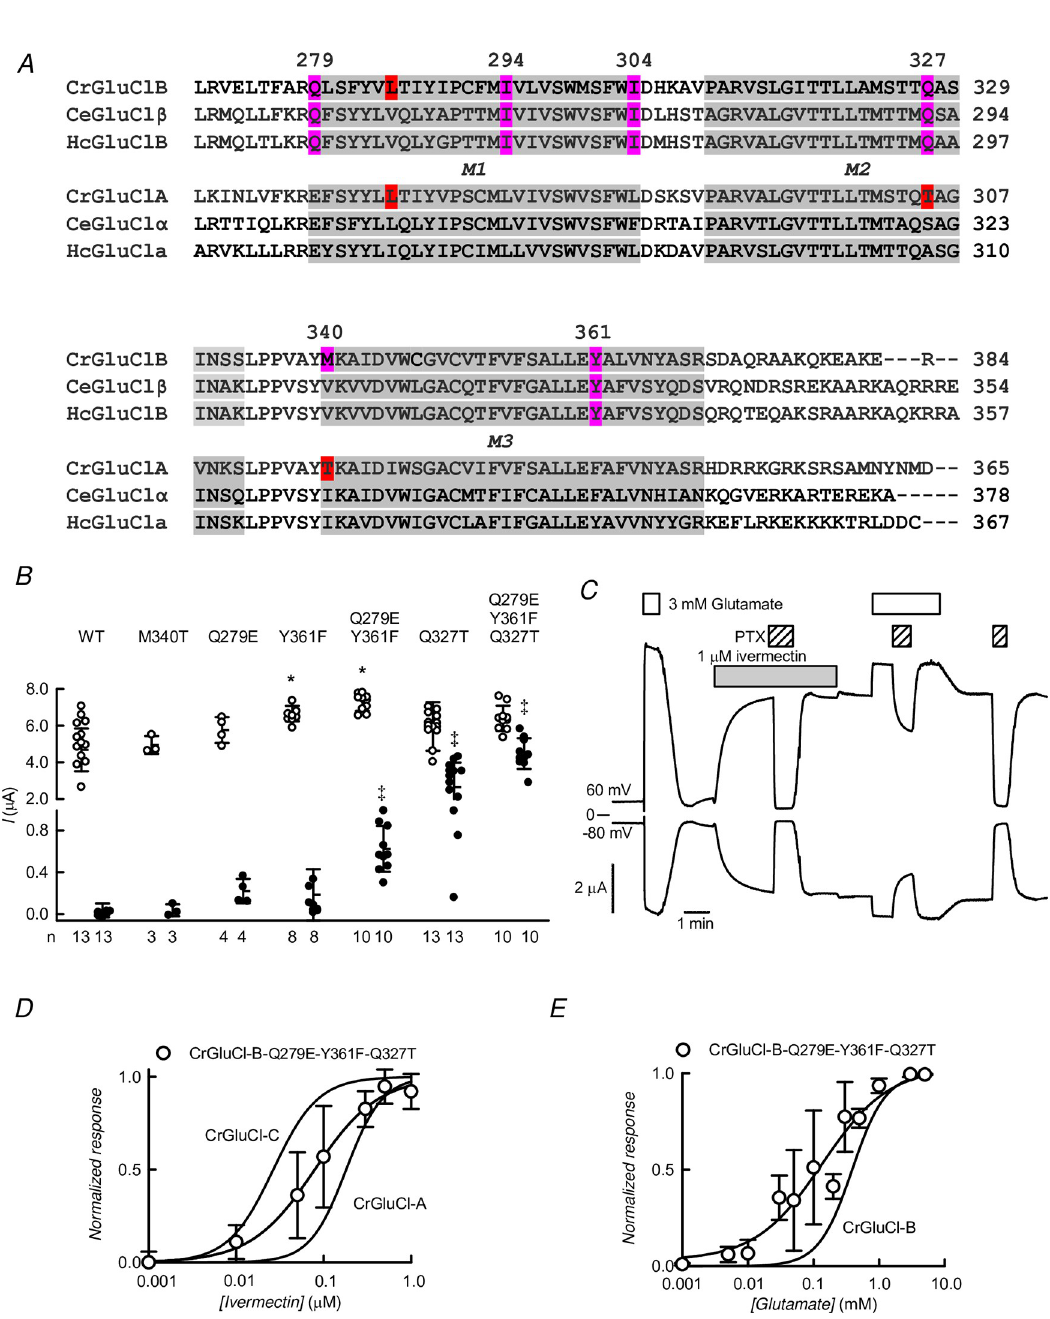
Fig 15. Mutational analysis of CrGluCl-B ivermectin-resistance. A. Partial sequence alignment of CrGluCl-B and CrGluCl-A. Also shown are homologous regions of GluCl α and β subunits of H . contortus and C . elegans . Highlighted in red are residues identified as interacting with ivermectin in docking experiments with CrGluCl-A. Magenta residues are those at variance between C . rogercresseyi GluCl A and B subunits and are conserved in the nematode respective subunits. B. Currents induced in CrGluCl-B WT or its indicated mutants by 3 mM glutamate (open circles) or 1 μ M ivermectin (black circles). Results are given as individual points and means ± SD given under the abscissa for WT CrGluCl-B and for its M340T, Q279E, Y361F, Q279E-Y361F, Q327T and Q279E-Y361F-Q327T mutants. ANOVA with Bonferroni correction analysis of the glutamate effect shows no significant difference between mutants and WT except as indicated by � (P < 0.001). Regarding ivermectin effect, one-sample t-tests showed significant effects of the drug in all cases, except for the WT receptor and for its M340T mutant. The effect of ivermectin on the mutants compared with that on the WT subunit reached significance as tested by ANOVA as indicated (‡, P < 0.05). C. Currents taken at 60 and -80 mV in a recording of the Q279E-Y361F-Q327T mutant. D and E. Concentration-dependence of the effects of ivermectin and glutamate on CrGluCl-B-Q279E-Y301F-Q327T triple mutant. Concentration-dependence data for ivermectin (panel D) are means ± SD with n = 8 and were normalised to the maximal effect evoked by ivermectin after a Hill equation was fitted to